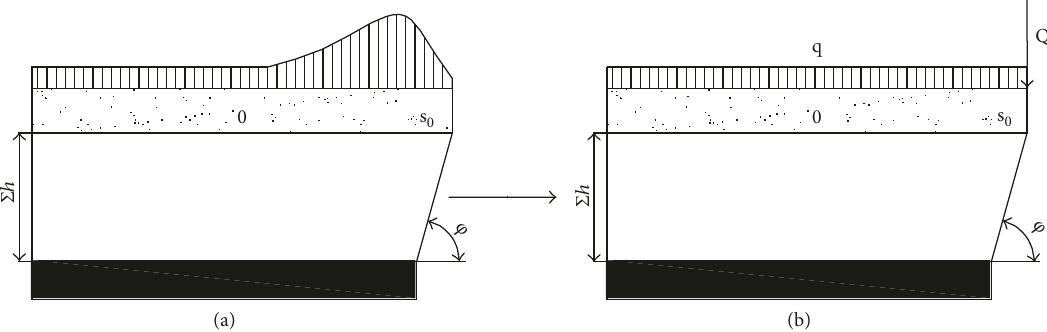
Figure 5: Mechanical state of the voussoir beam above the rib side. (a) Plastic foundation; (b) elastic